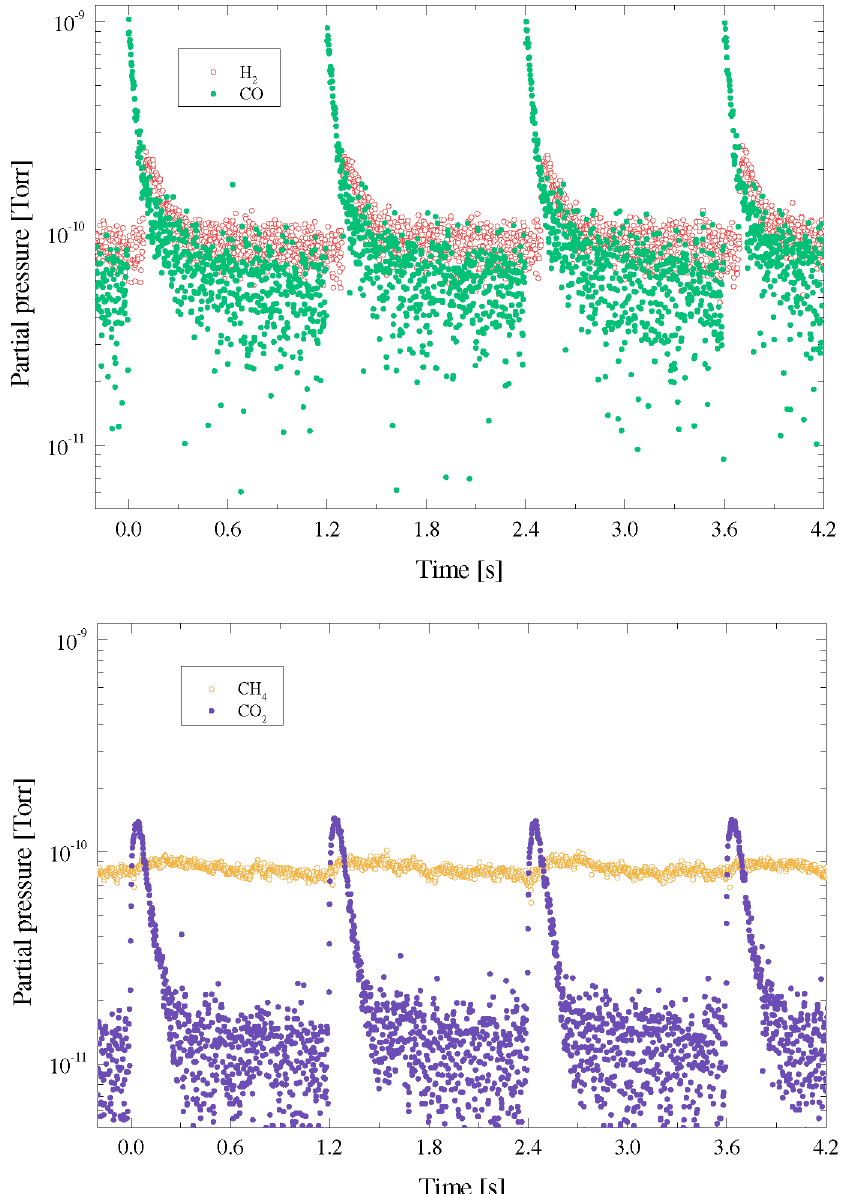
FIG. 8. (Color) Partial pressures measured for the NEG-coated vacuum chamber C (activated at 300 (cid:7) C ) with pulses of 1 : 5 (cid:2) 10 9 Pb 53 (cid:1) ions every 1.2 s impacting at 89.2 (cid:7) grazing and CO, lower curve: CH and CO incidence. Upper curve: H 2 4 2